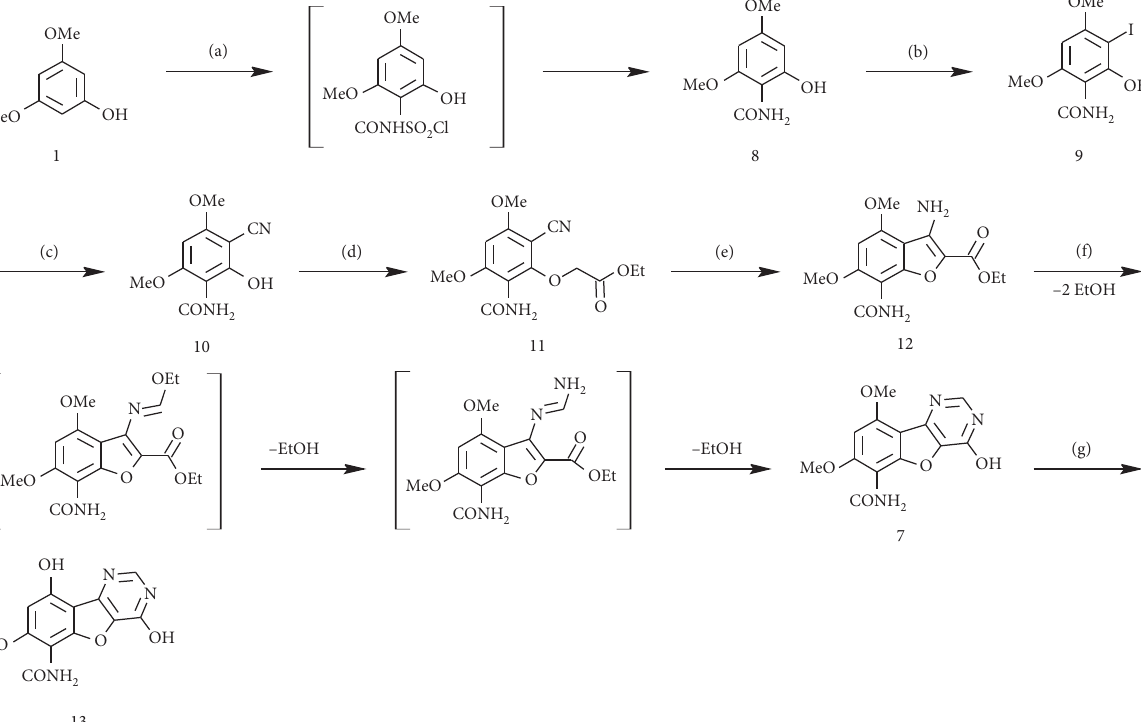
° C, 10 min, 60%. (c) CuCN, DMF, 160 ° C, 6h, 38%. 2 Cl 2 , 0